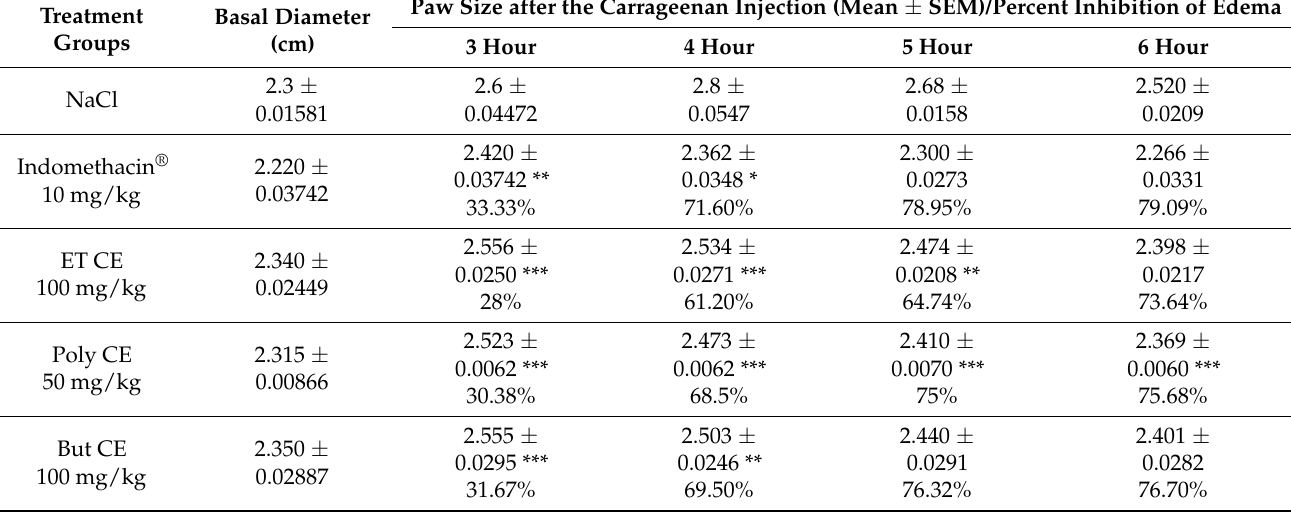
Table 4. Anti-inflammatory effects of C. europaea fractions on carrageenan-induced paw edema.